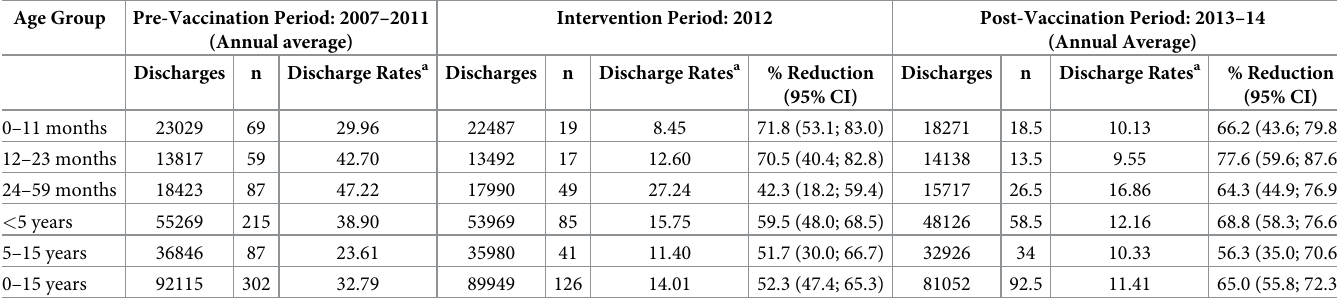
Table 2. Pneumococcal pneumonia discharge rates by age. PCV13 vaccination impact. Age Group Pre-Vaccination Period: 2007–2011 Intervention Period: 2012 Post-Vaccination Period: 2013–14 (Annual average)